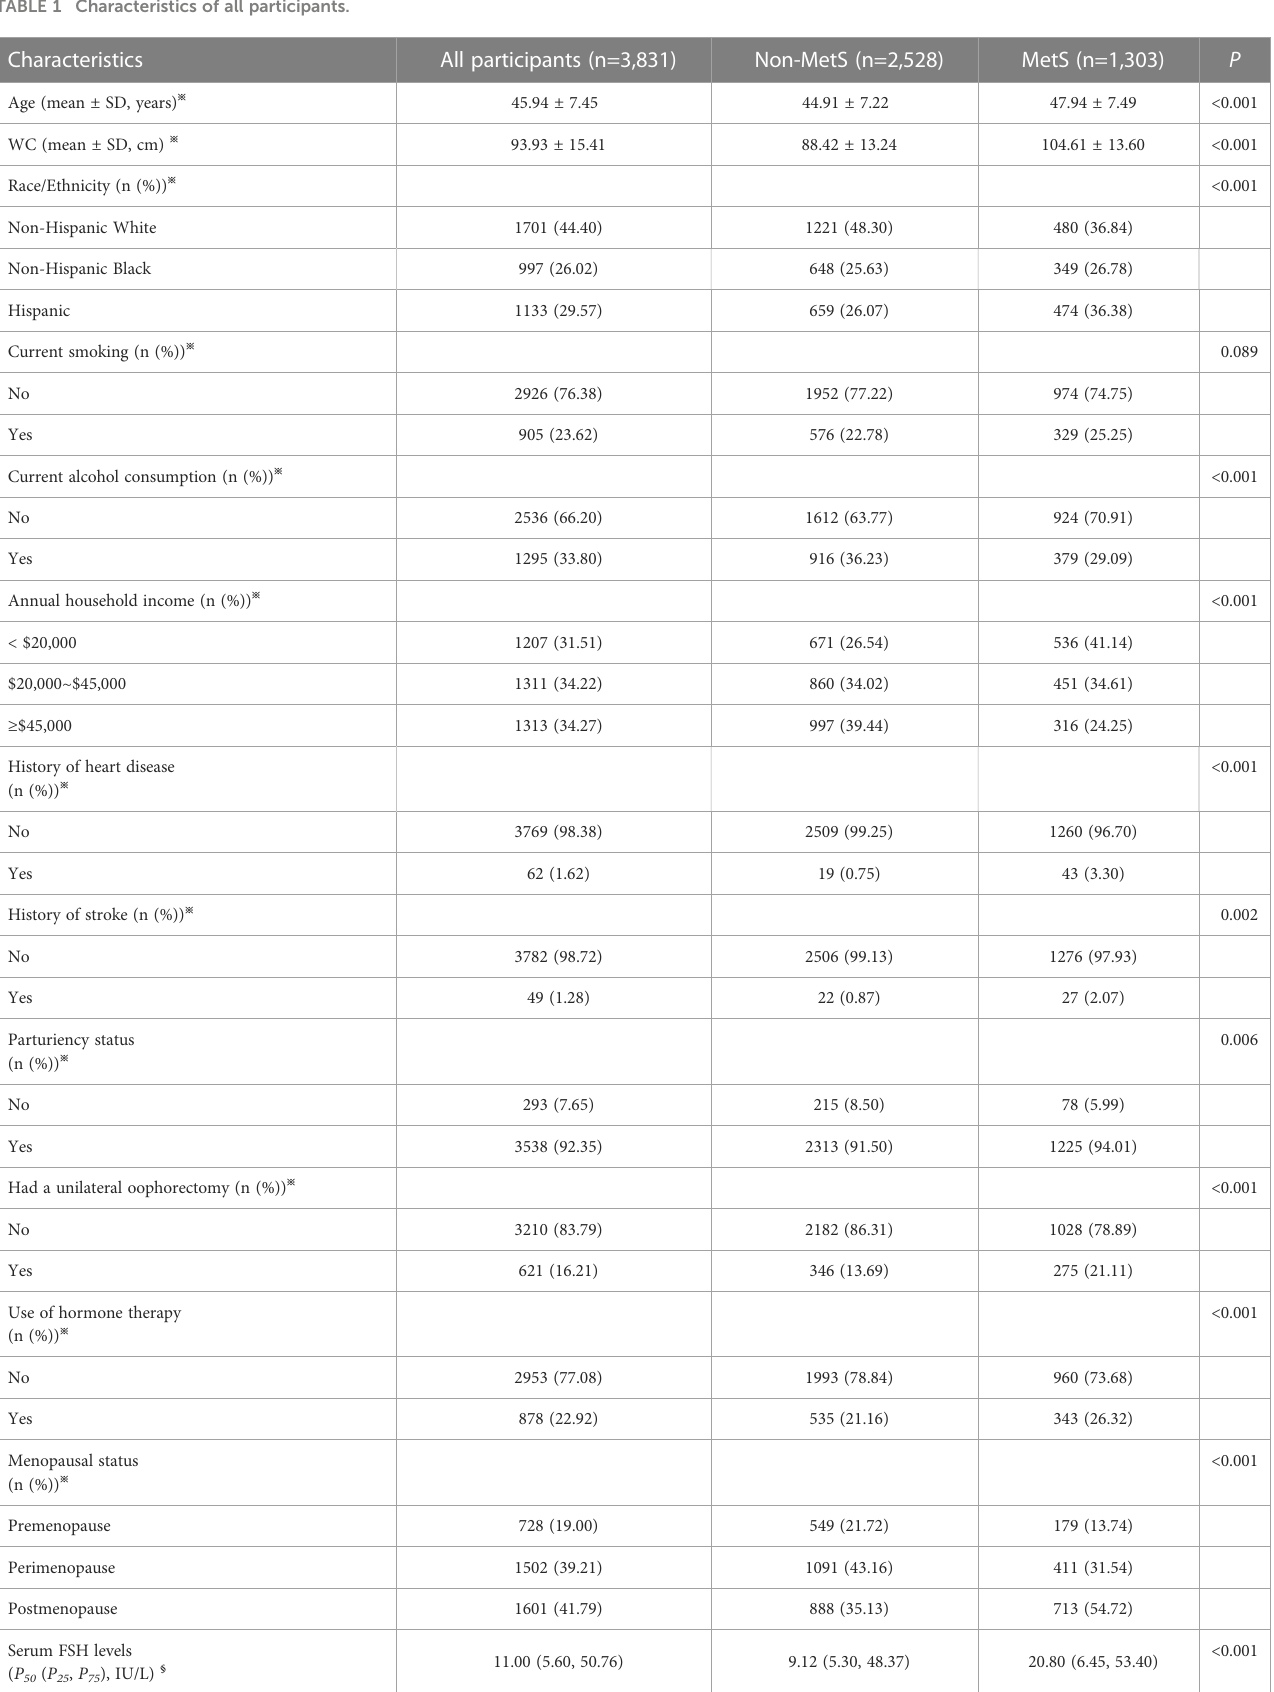
TABLE 1 Characteristics of all